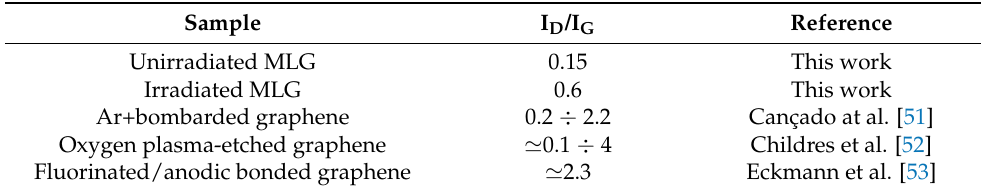
Table 4. I D /I G ratio of graphene.